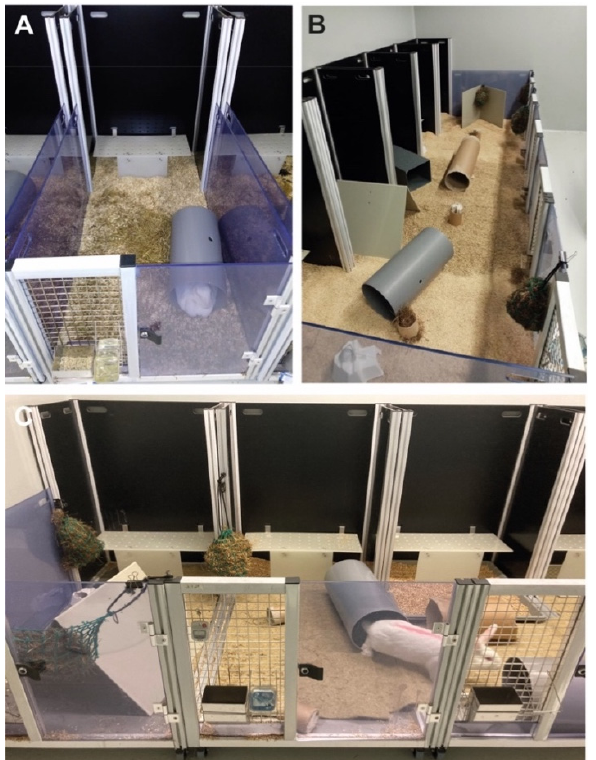
Figure 2. Set-up for a single-housed rabbit ( A ) or group-housed animals ( B , C ) in a